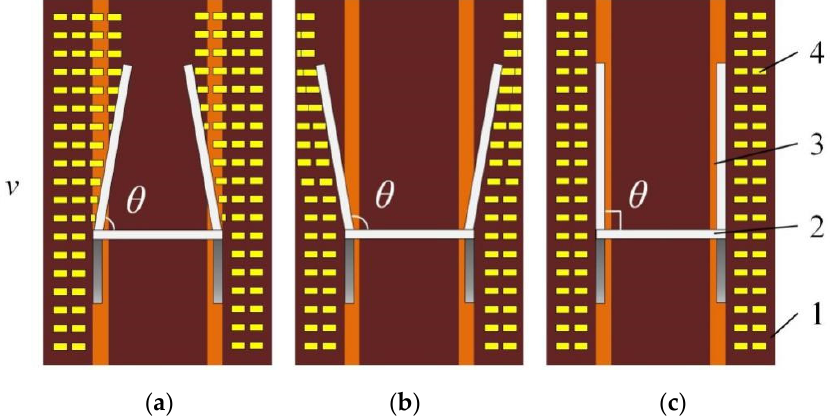
Figure 5. Effect of θ on cleaning effect of seed strip. ( a ) θ < 90°; ( b ) θ > 90°; ( c ) θ = 90°. Note: 1, no-tillage surface of the field; 2, RSM; 3, seed line; 4, straw.